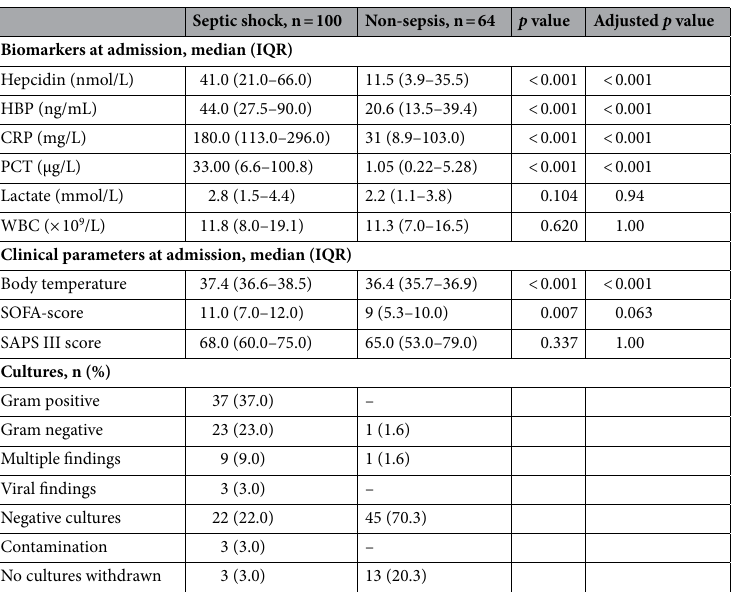
Table 2. Laboratory and clinical evaluation measurements at enrolment. Bonferroni corrected p value for 9